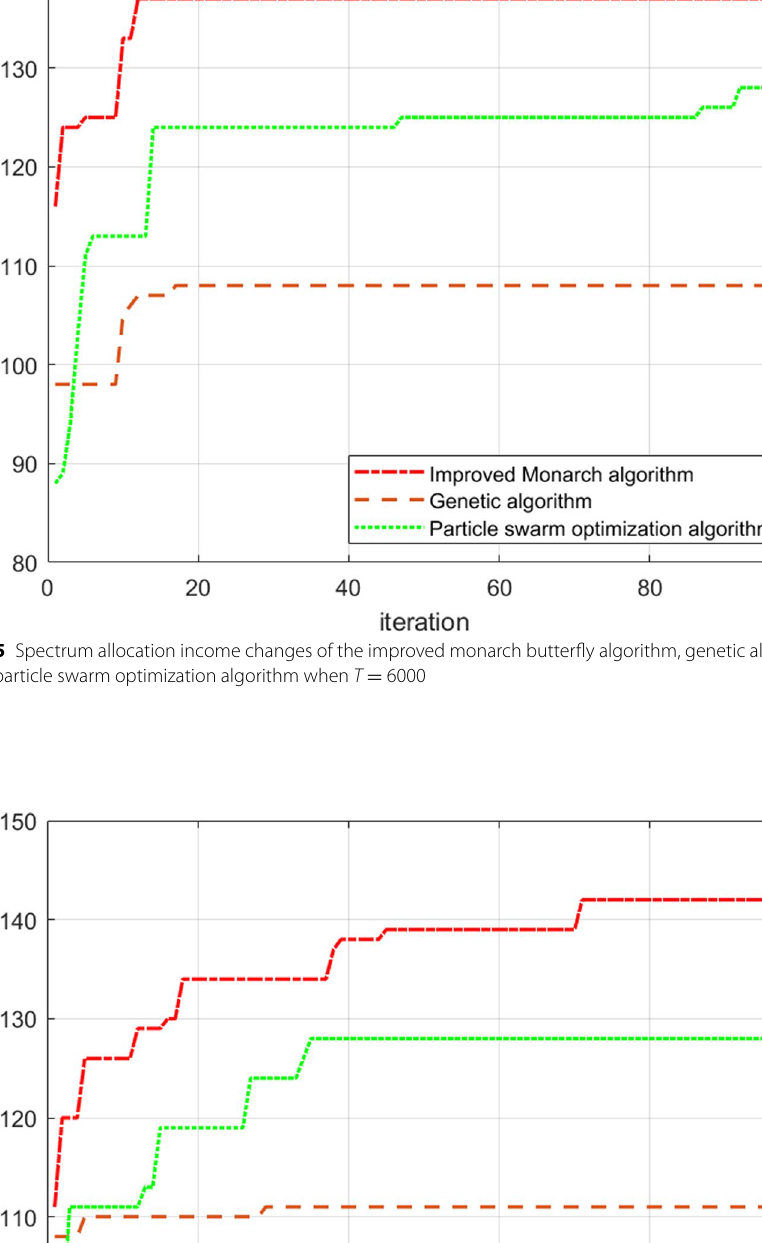
Fig. 6 Spectrum allocation income changes of the improved monarch butterfly algorithm, genetic algorithm and particle swarm optimization algorithm when T =